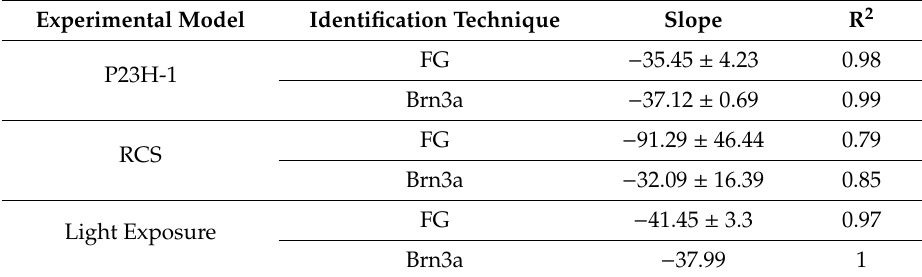
Table 1. Slope and correlation coe ffi cients (R 2 ) of each straight line from Figure